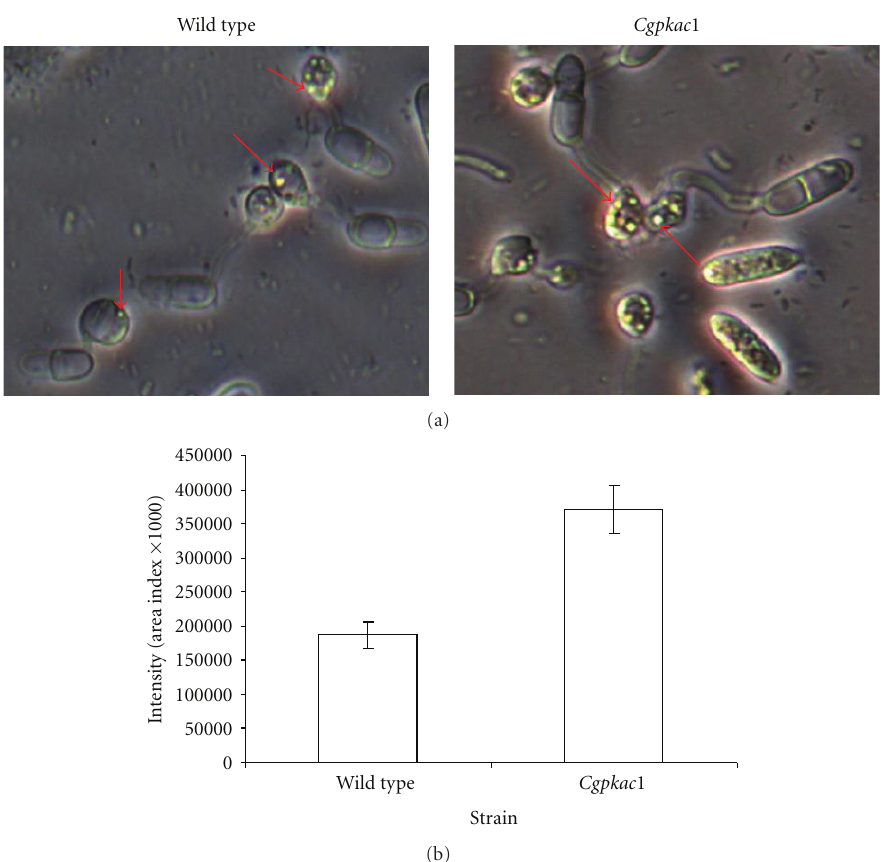
Figure 8: Cellular distribution of lipid droplets in C. gloeosporioides wild type and the Cgpkac1 mutant. (a) The presence of Nile-Red-stained lipid appressoria was observed with a Leica phase contrast microscope (400x magnification). Arrows indicate fluorescent lipid stained with 10 μ g of Nile Red. (b) Area index indicating lipid content in appressoria of the wild-type strain and Cgpkac1 mutant was based on analysis using AlphaEaseFC Software.